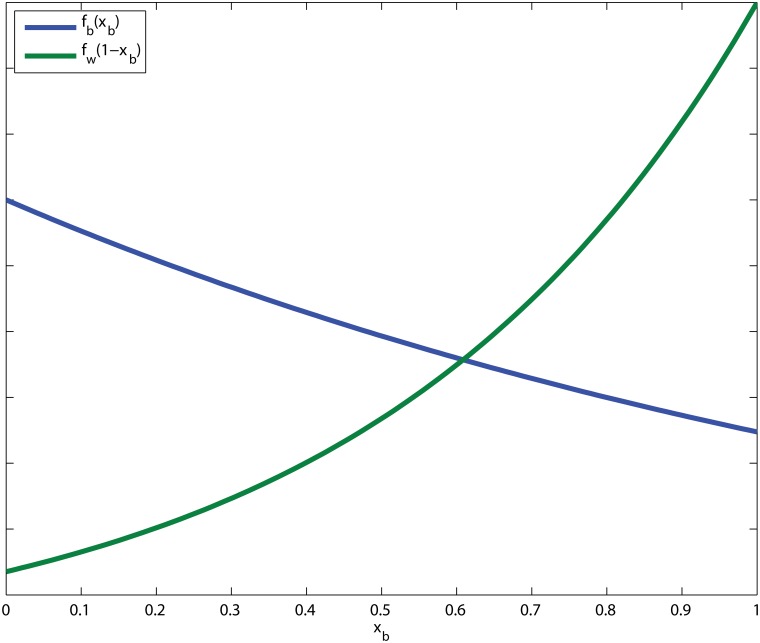
The potential frequency functions f
b(x
b) and f
w(1 − x
b).